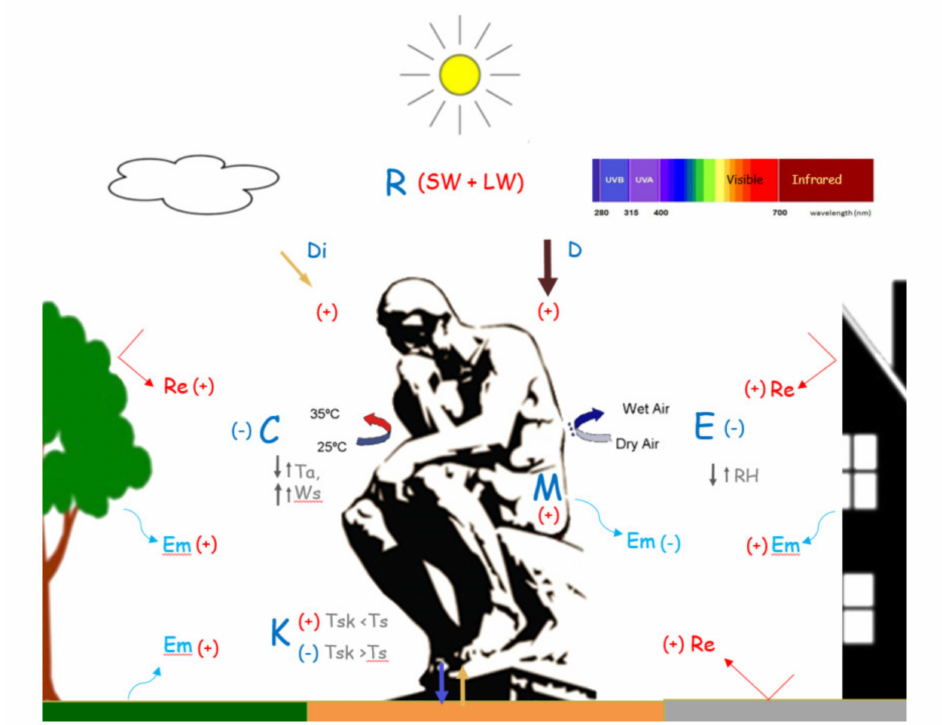
Figure 1. Energy fluxes that a ff ect the human energy budget